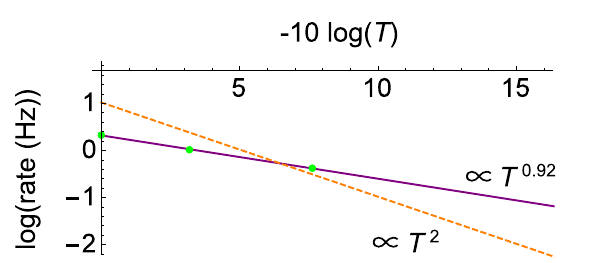
Table 1. The experimental results of the fidelity F , purity P and EoF E of the reconstructed density operators distributed by our scheme for each transmittance T . Fidelity th is the value predicted by the theoretical model with the experimental parameters, in which the error bars come from the observed values of the visibility between the light pulses at Alice’s side.